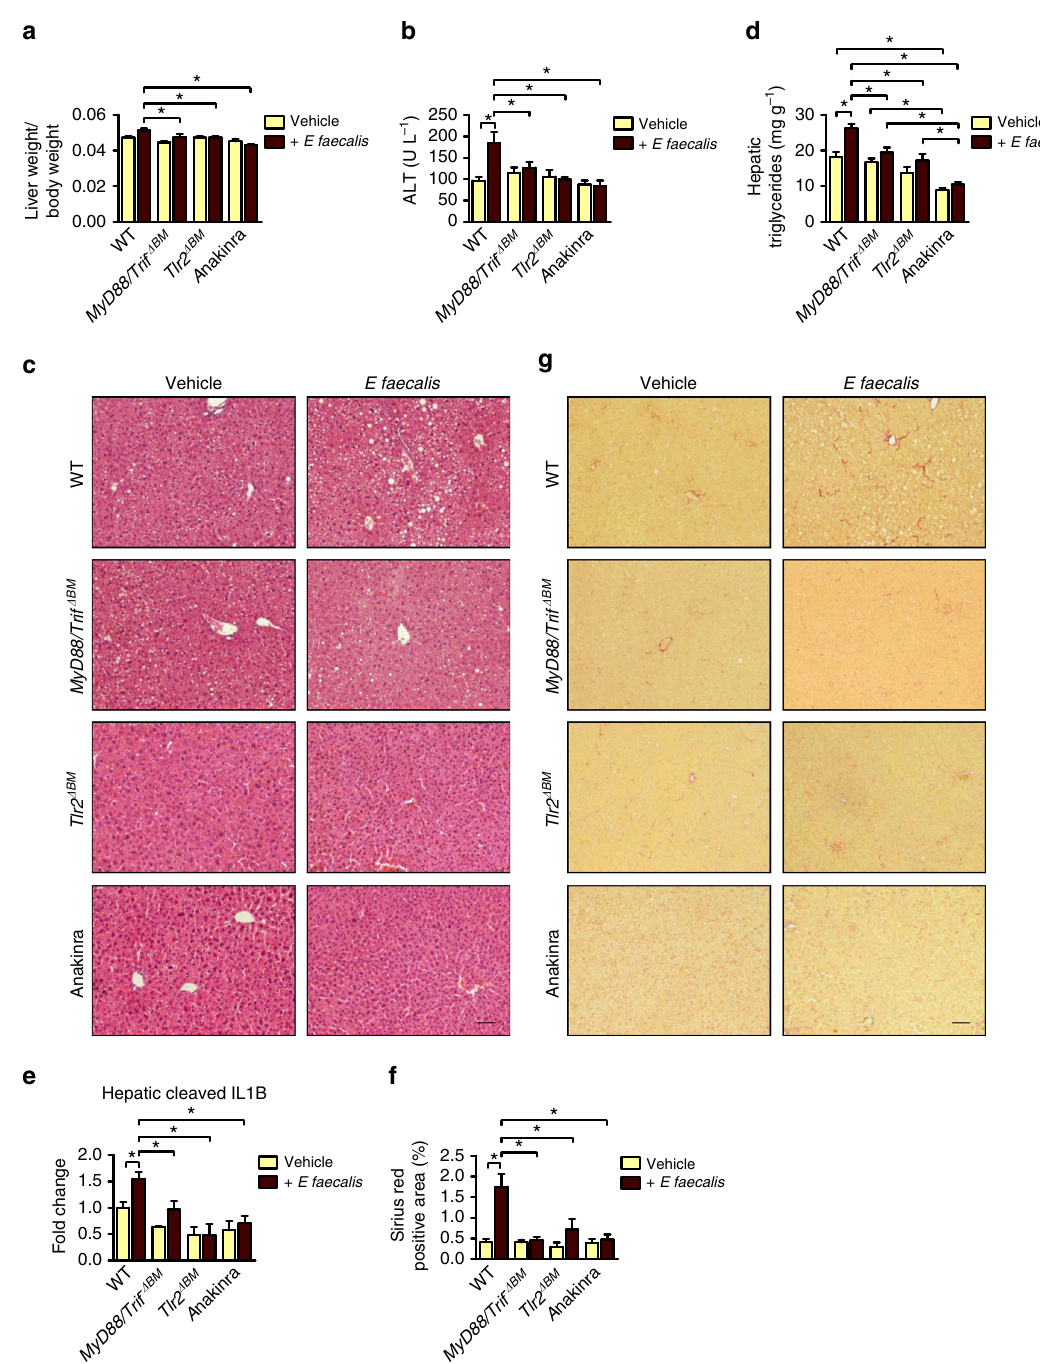
Fig. 7 MYD88/TRIF, TLR2 or IL1-receptor inhibition protects from E. faecalis -exacerbated alcoholic liver disease. C57BL/6 mice were irradiated, given transplants of WT, Myd88 − / − /Trif LPS2/LPS2 ( Myd88/Trif Δ BM ), or Tlr2 − / − bone marrow ( Tlr2 Δ BM ) and injected with clodronate liposomes. Mice were then gavaged with polymyxin B 150 mg kg − 1 and neomycin 200 mg kg − 1 body weight once daily for 1 week to facilitate colonization of E. faecalis , fed the ethanol diet for 9 weeks, and gavaged with E. faecalis (5 × 10 9 CFUs; n = 14 – 27; 1 – 3 replicates) or vehicle (water; n = 14 – 29) (1 – 3 replicates) every third day. A subset of WT mice given transplants of WT bone marrow received the IL1-receptor antagonist anakinra. a Ratio of liver to body weight. b Plasma levels of ALT. c Representative liver sections after hematoxylin and eosin staining. d Hepatic triglyceride content. e Hepatic levels of cleaved IL1B ( n = 3). f Hepatic areas of fi brosis were identi fi ed by staining with Sirius red; area was quanti fi ed by image analysis software ( n = 6 – 17). g Representative Sirius red-stained liver sections. Scale bar = 100 μ m. Results are expressed as mean ± s.e.m. For a , b , d – f signi fi cance was evaluated using one-way analysis of variance with Newman – Keuls post-test. * P <